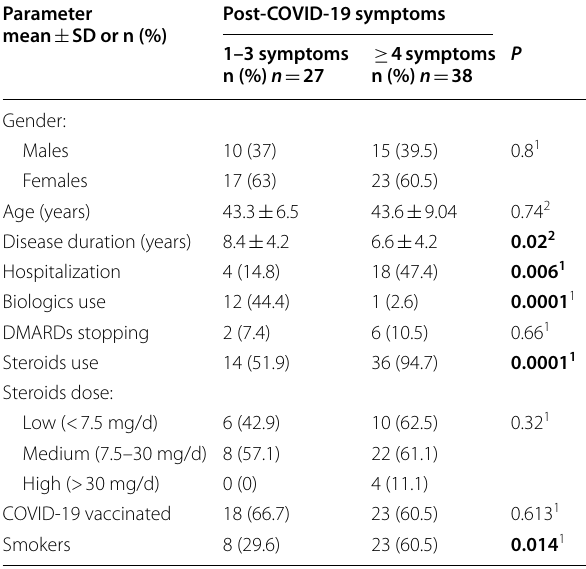
Table 3 Distribution of variables according to the number of post-COVID-19 symptoms in rheumatic disease patients